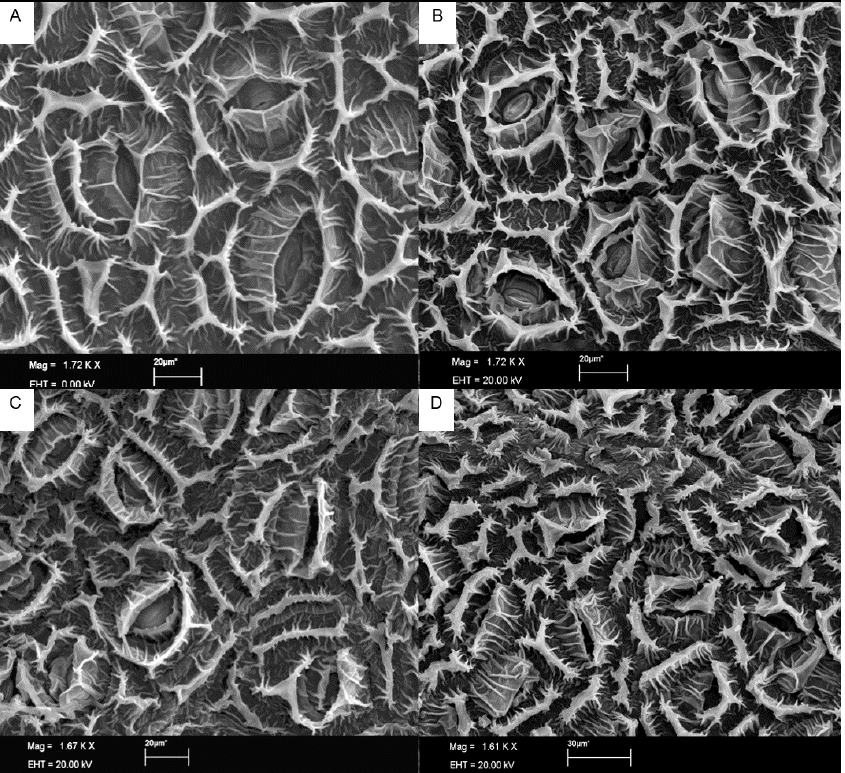
Figure 8. Scanning electron microscopy photos of stomata in the leaves of rubber tree clones IAC 502 ( A ), IAC 507 ( B ), RRIM 937 ( C ) and RRIM 600 ( D ).